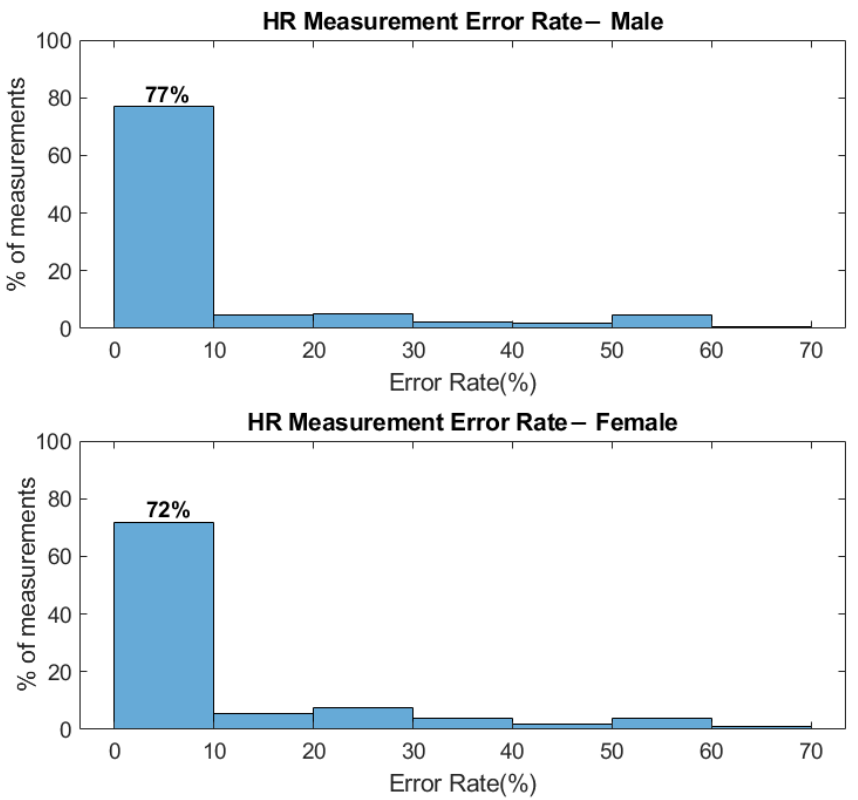
Figure 16. HR measurements error rate within groups of: male ( top ) and female ( bottom ). In terms of age, we separated the participants into a younger group (21/29 partici- pants) and an elder group (8/29 participants) at the threshold of 35 years old. The success rate/mean deviation is 84%/ − 7.7 BPM for the elder group and 71%/ − 5.89 BPM for the younger group (Figures 18 and 19). The higher success rate among the elder